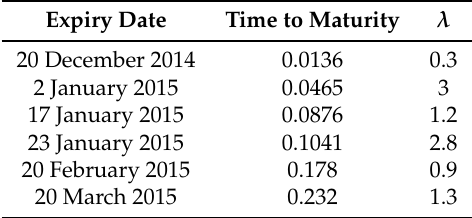
Table 1. Times to maturity and the optimum values of the regularization parameter for each volatility